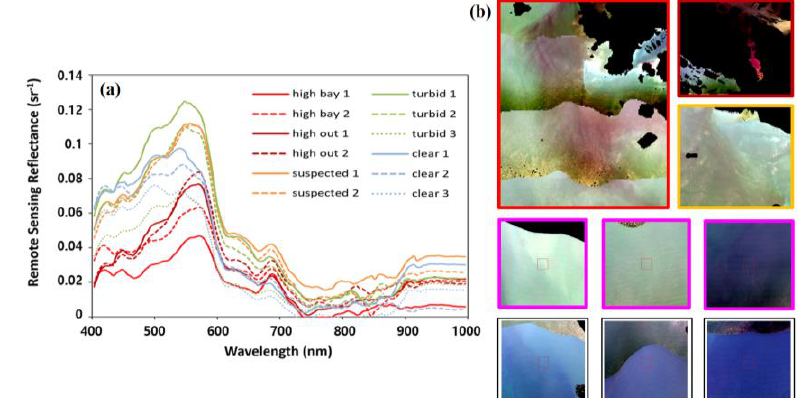
Figure 11 . (a) Extracted R rs spectrum from atmospheric-corrected airborne hyperspectral images and (b) patches from which R rs spectrum data were extracted (Each patch’s color matches with the patches in figure